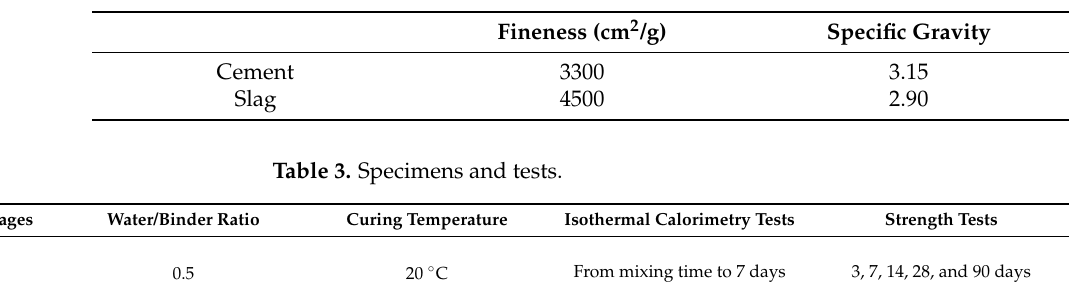
Table 2. Physical properties of the binder components.